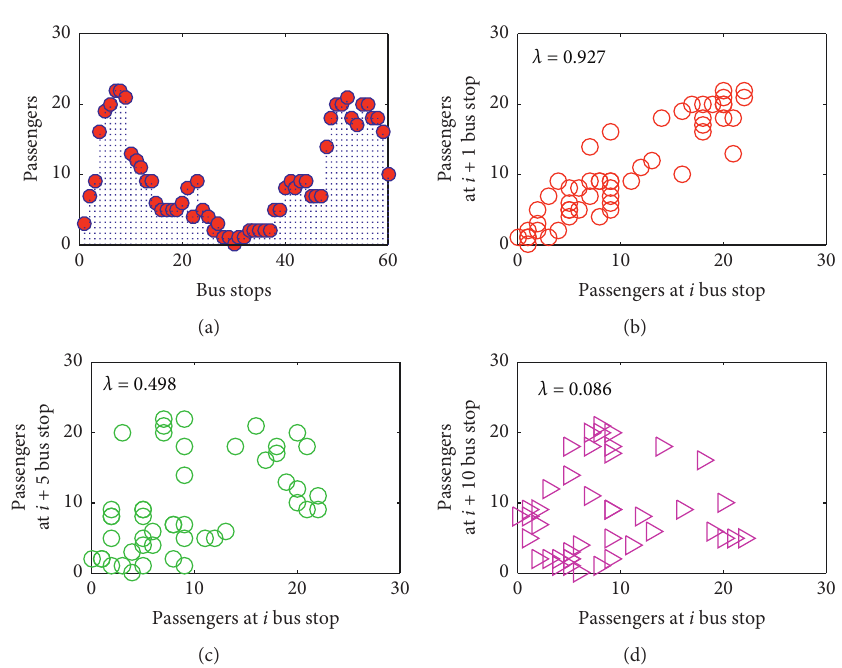
Figure 12: Measured passenger data and the correlation analysis for off-peak hours. (a) Measured data. (b) 1-step transition. (c) 5-step transition. (d) 10-step